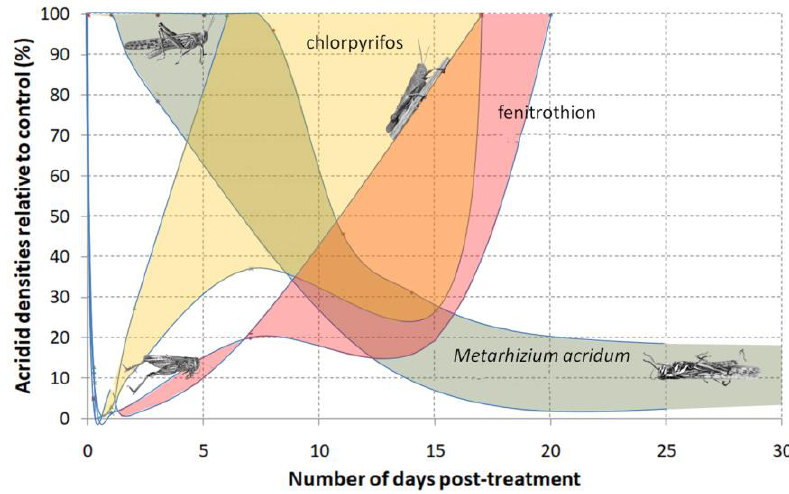
Figure A1. Densities of acridids in the first month following sprays with either chlorpyrifos, fenitrothion or M. acridum .